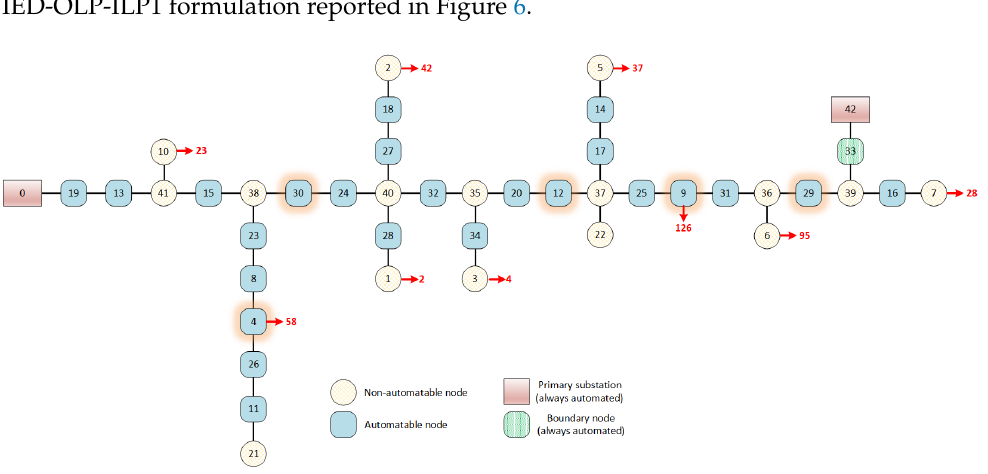
In Figure 7, the provided solution with five IEDs and CD = 30% is shown. It can be seen that the optimal IEDs position changed when compared with that provided by